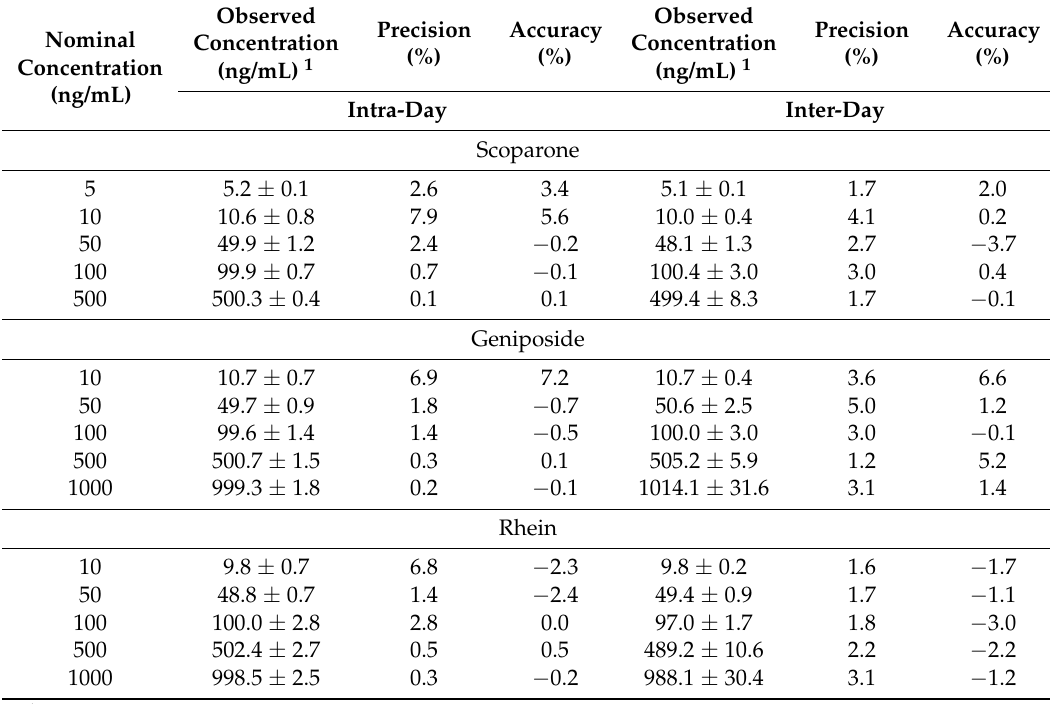
Table 3. Intra-day and inter-day precision and accuracy of scoparone, geniposide and rhein in plasma